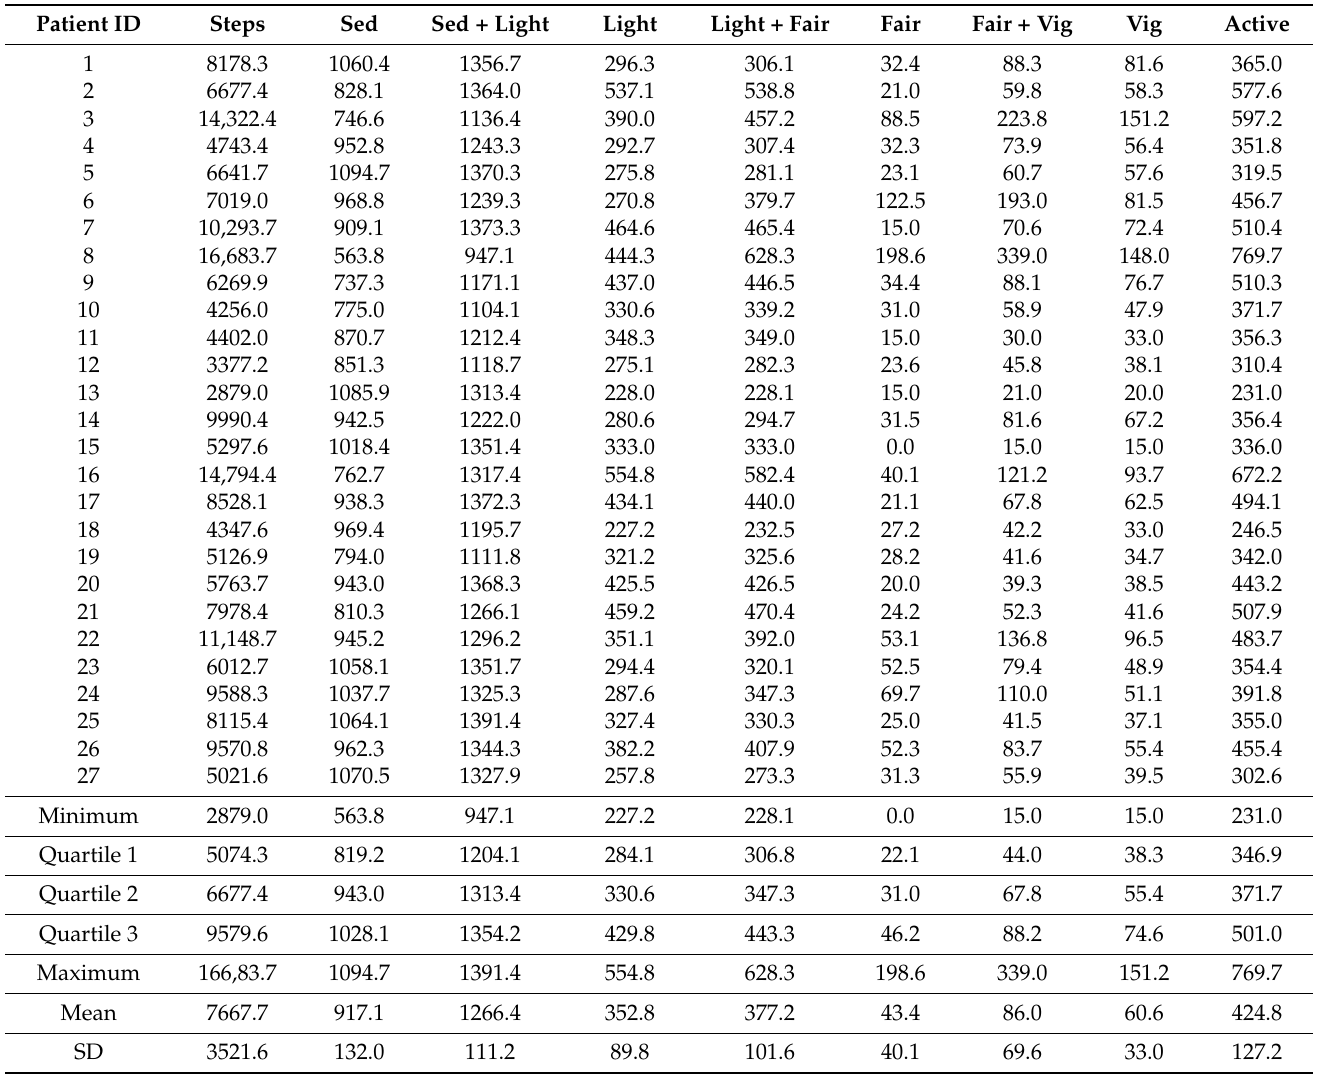
Table A6. Mean Fitbit steps and durations of physical activity intensities over the entire Fitbit observation time (27 patients).